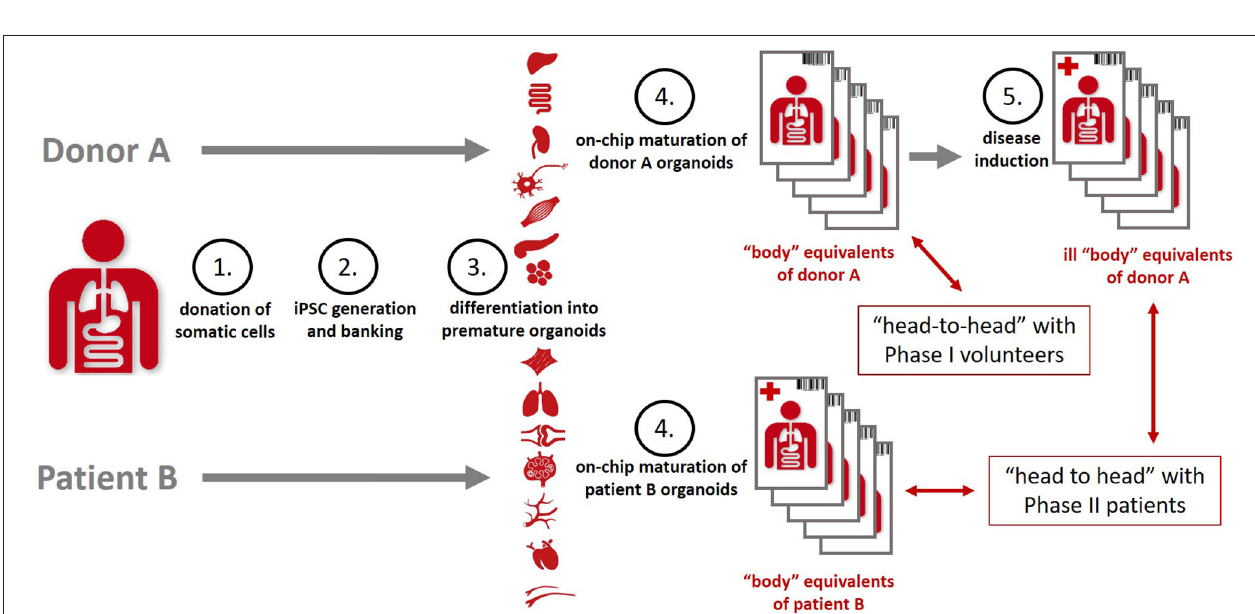
FIGURE 6 | Organismoids—“body” equivalents—in the context of potential “clinical trials” on chips [adopted from (10)].